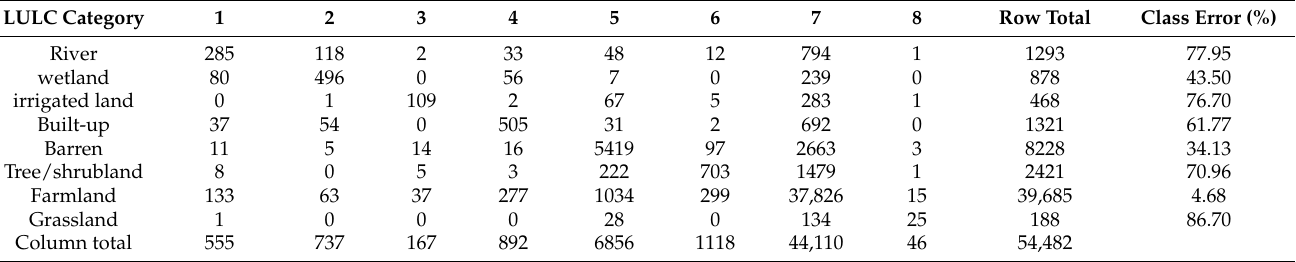
OOB confusion matrix for Sentinel 1 (Scenario 2) classification